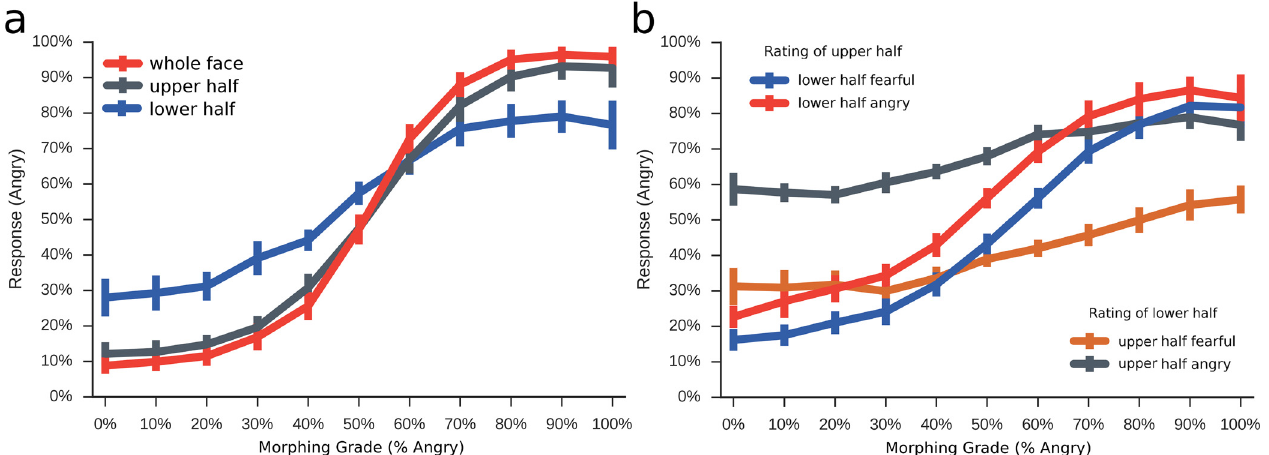
Fig 9. Correction for different thresholds between face identities. Main analyses for both experiments after modelling responses to each face identity individually and shifting the thresholds to be at the respective group mean; a, results for experiment 1 (masking); b, results for experiment 2 (composite faces); note that a different number of data points is available for each bin on the x-axis, as functions may be partly shifted out of the displayed range, rendering estimates at the extremes less reliable; also, variability is modelled at the stimulus level, not at participant level; please refer to S6 Code for more details on the analysis